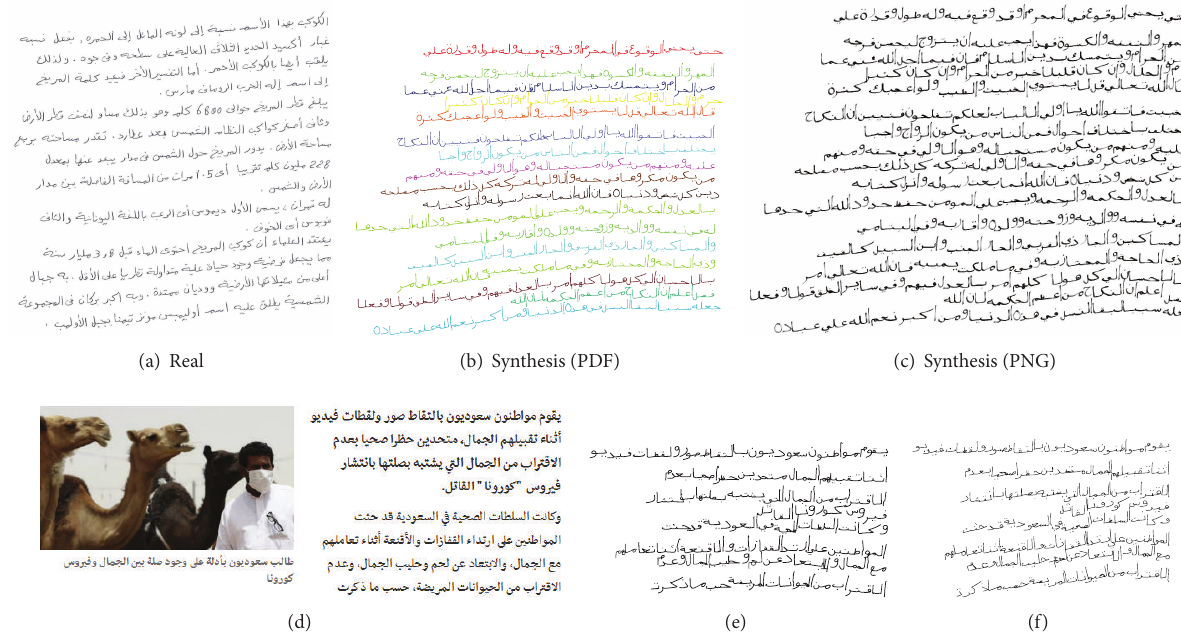
Figure 14: Examples for syntheses of complete text pages: (a) one of the natural handwritings that have been used to compute function 𝑓 ; (b) synthesis using optimized 𝑓 1 (given by (15)), rendered as PDF; (c) another synthesis using 𝑓 1 , rendered as png image. More examples inclusive ground truth will be added at http://www.iesk-ardb.ovgu.de/ soon. Text synthesis from a BBC newsletter (d); BBC article about a